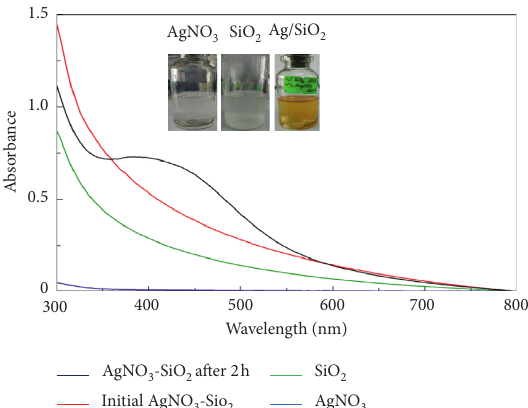
Figure 1: UV-vis absorption spectra of the solutions of AgNO